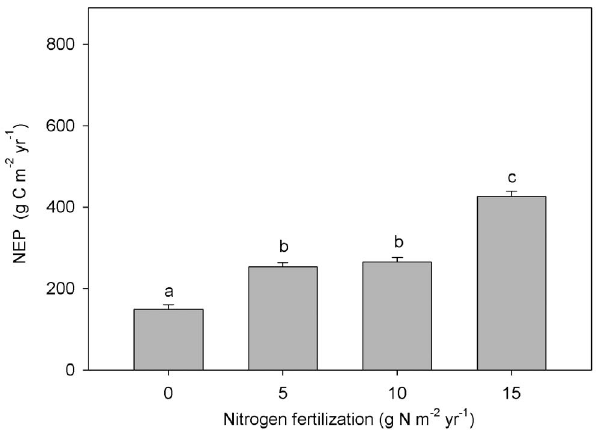
Figure 4. Net ecosystem productivity (NEP) in control and nitrogen (N) fertilized treatments. Significant differences among N